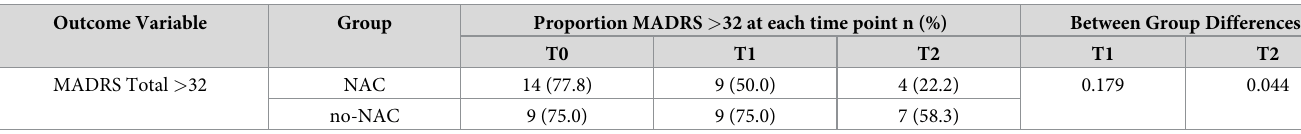
Table 2. MADRS > 32 –between group